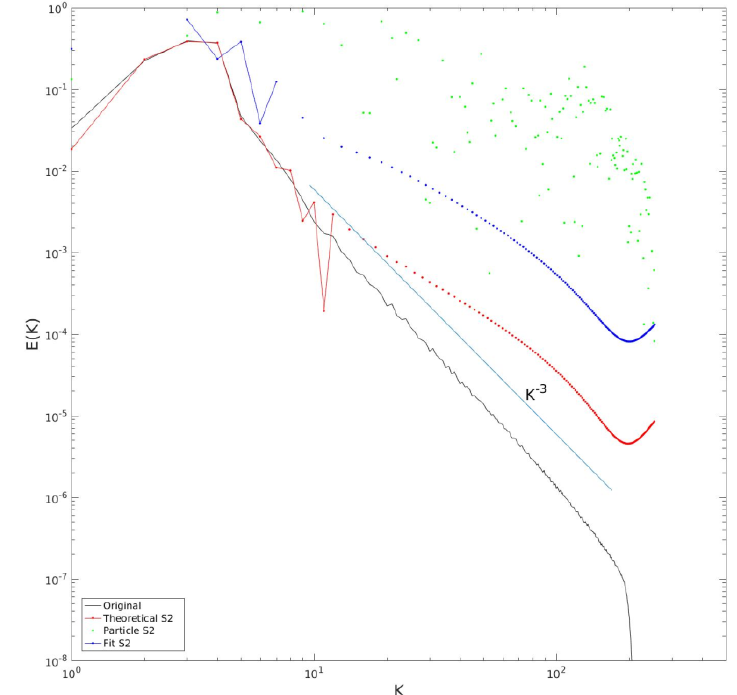
Figure 12. As in Figure 11, but with a simulation of a 2D enstrophy cascade, forced in the range K = [ 1,5 ]